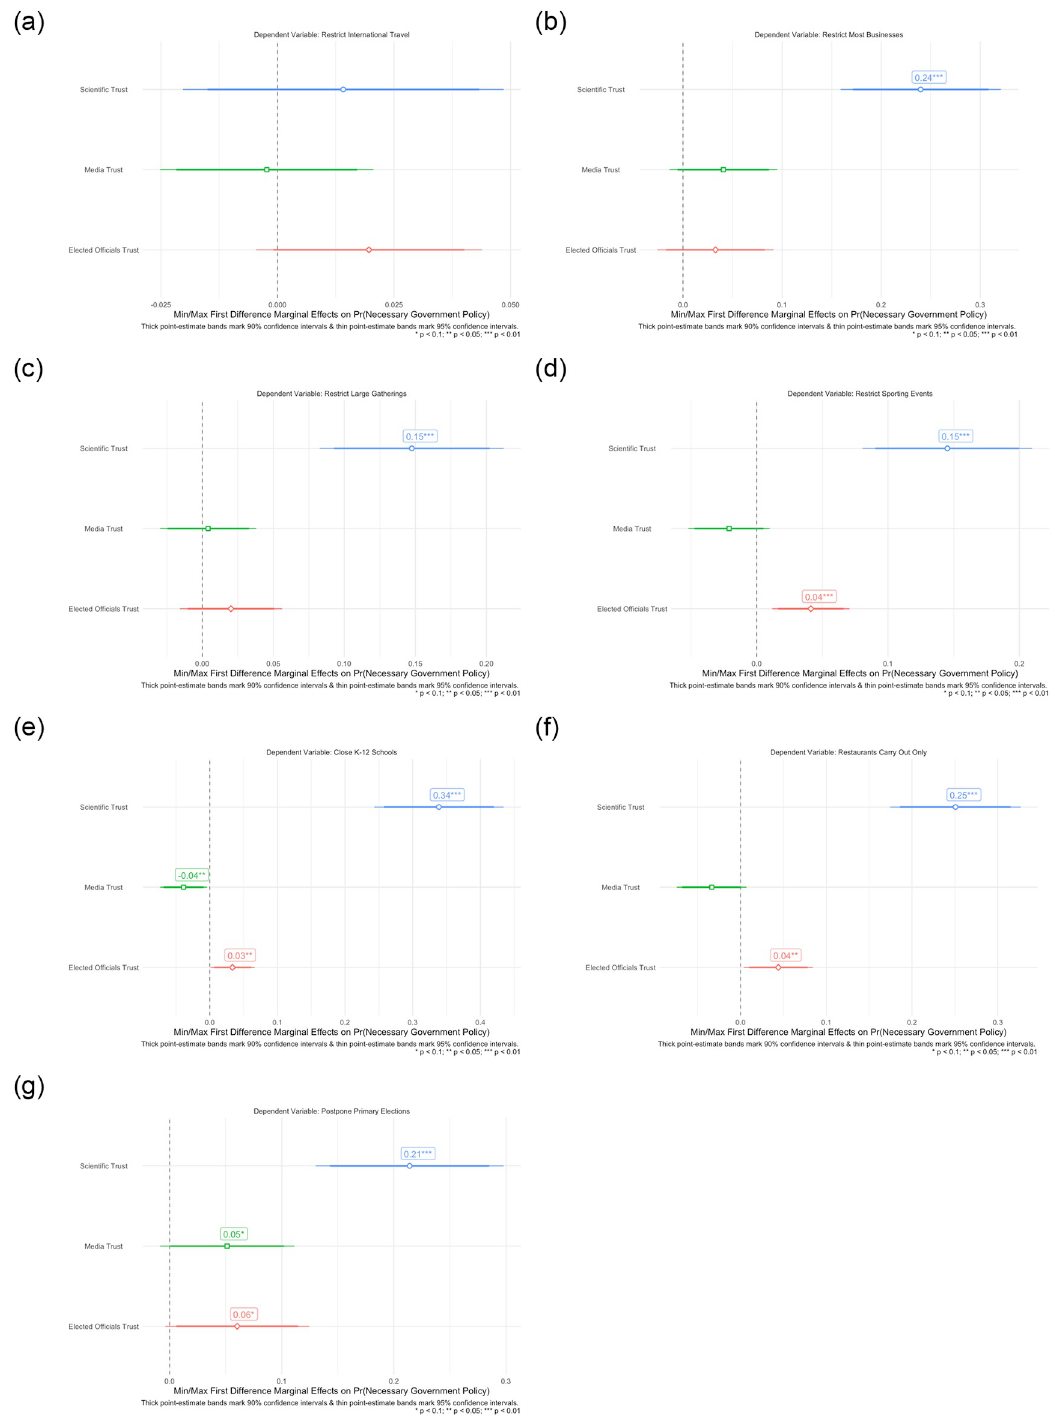
Fig 3. Baseline model effects of scientific, media, & institutional trust on specific COVID-19 social distancing policy support. A: Restrict international travel. B: Close most businesses. C: Restrict large gatherings. D: Restrict major large & sporting events. E: Restrict K–12 schooling. F: Restrict restaurant dining. G: Postpone primary